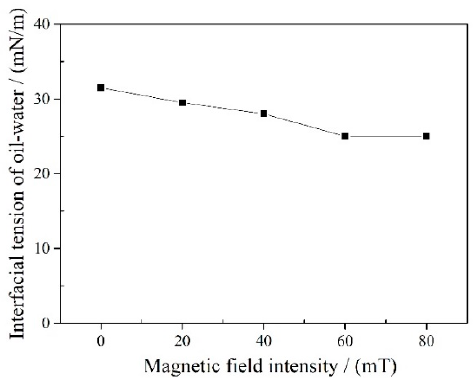
Figure 8. The influence of magnetic field intensity on the interfacial tension of kerosene–water (303 K) [28].